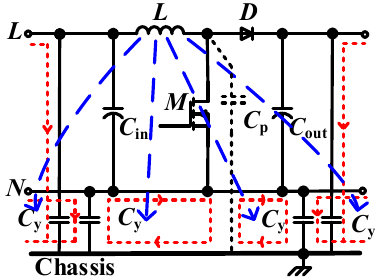
Figure 7. Magnetic couplings among the toroidal inductor and CM paths.